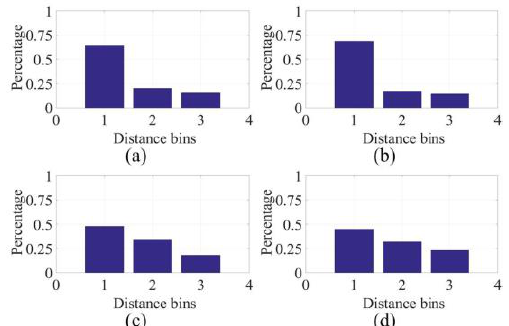
Figure 15. Feature histograms for one point in different clusters.